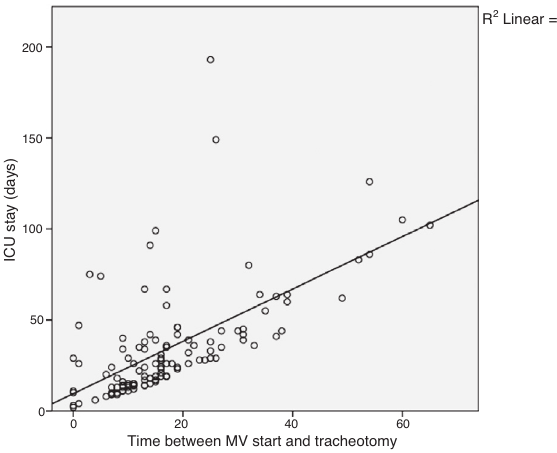
Figure 4 Spearman’s correlation: correlation was found between the duration of ICU stay and timing of tracheotomy (time between MV start and tracheotomy) − R 2 = 0.37. although with a tendency to lower mortality in ET group (11.1% vs. 24.8%). None of the deaths were attributed to the tracheotomy